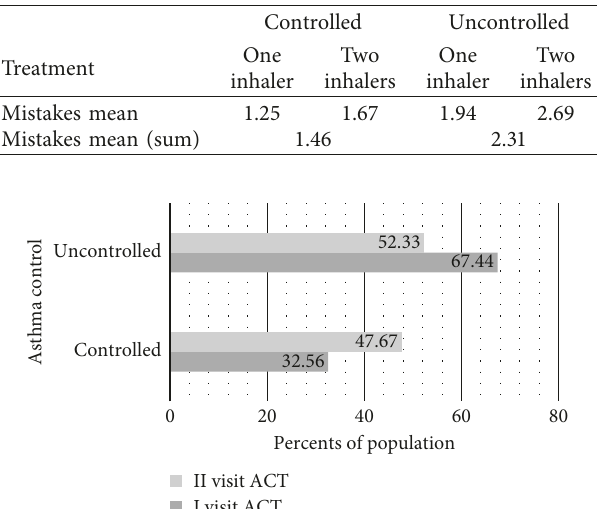
Figure 2: Asthma control by medication. Table 5: Asthma control by mistakes in inhaler